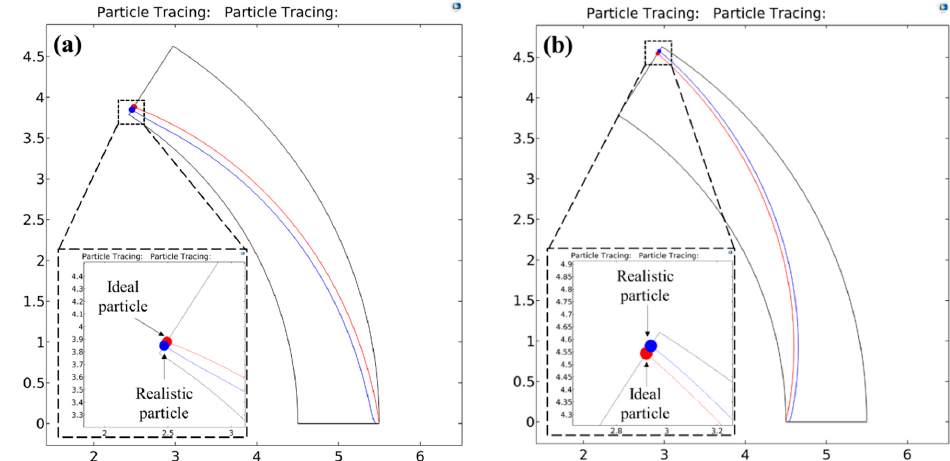
Figure 4. Numerically predicted path-lines for the ideal and realistic test particles under the action of ( a ) positive DEP ( Real ( f CM ) = 0.5) and ( b ) negative DEP ( Real ( f CM ) = − 0.5) inside a circular arc microchannel having a curvature ratio R C ∗ of 5. The dimensionless particle diameter d ∗ is chosen as 0.08 for positive DEP and its motion is driven by a dimensionless voltage of (cid:12) V App (cid:12) = 1404.85. Similarly, the dimensionless particle diameter d ∗ is chosen as 0.05 for negtive DEP and its motion is driven by a dimensionless voltage of (cid:12) V App (cid:12) = 3569.5. These particle sizes clearly demonstrate a regime 2 behaviour, where the design parameters for the C-iDEP microchannel can be determined reasonably by the exact solution but more reliably by the curve fitting